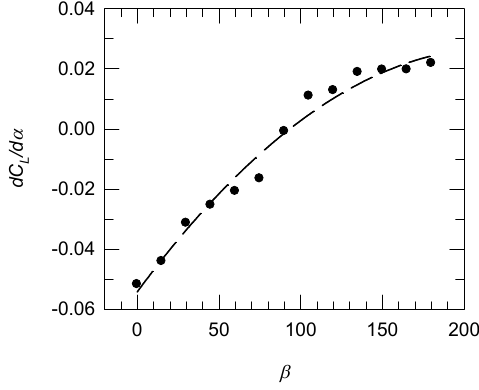
Figure 14. The e ff ect of β on dC L / d α